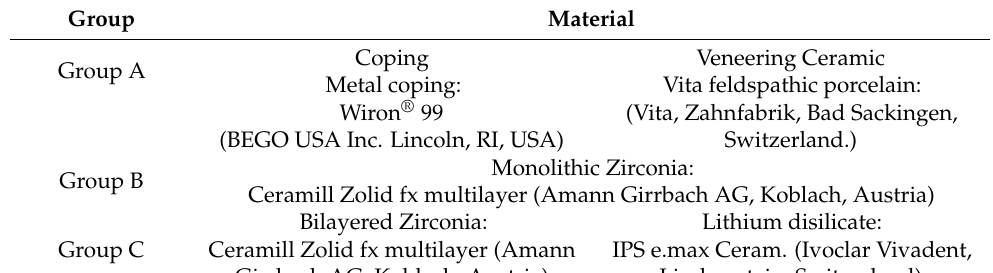
Figure 2. ( a ) Wax pattern of a mandibular first molar; ( b ) occlusal view of the wax pattern of a mandibular first molar. Table 1. Details of the implant system and crown